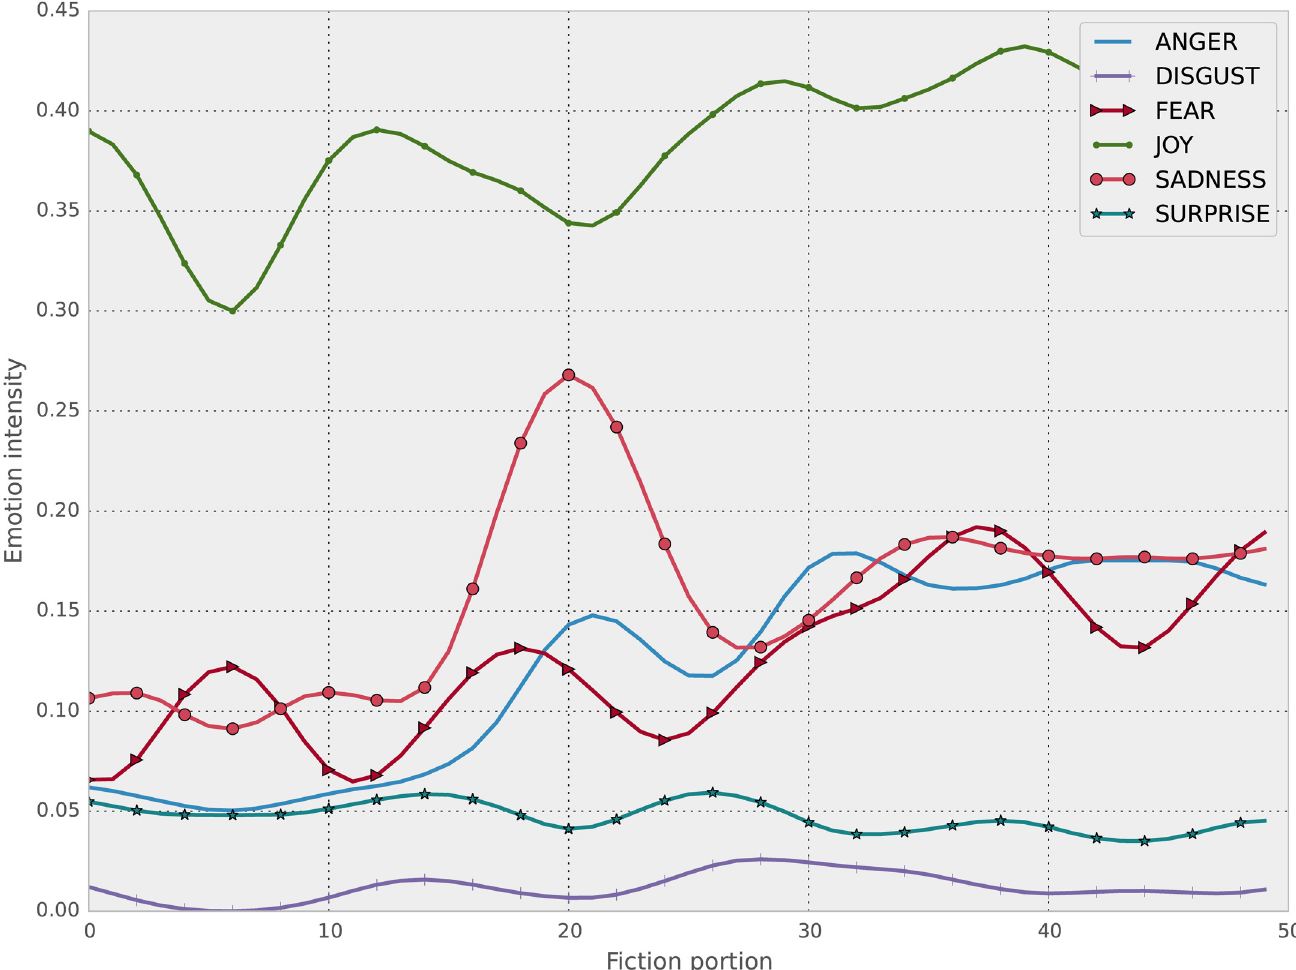
Fig 2. Emotional content for F RANKENSTEIN , by M ARY W. S HELLEY , of class H ORROR .